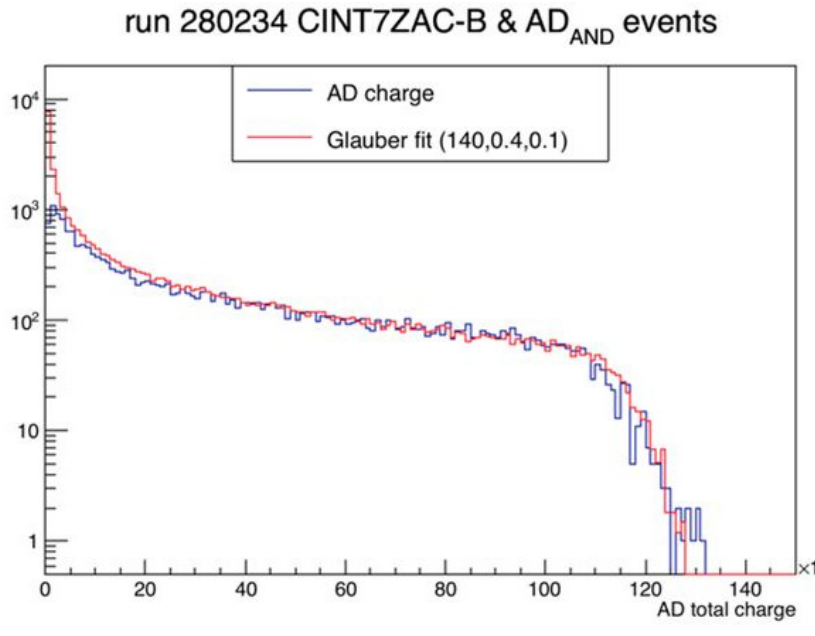
Figure 1. Multiplicity distribution for Xe – Xe collisions at 5